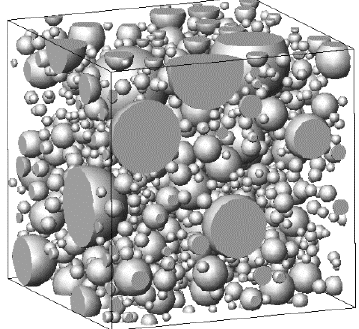
Figure 1. Initial distribution of cement particles.